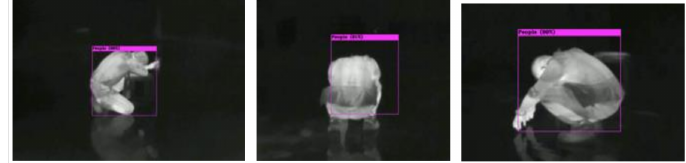
Figure 15. Detection of squatting human from different viewing angles.